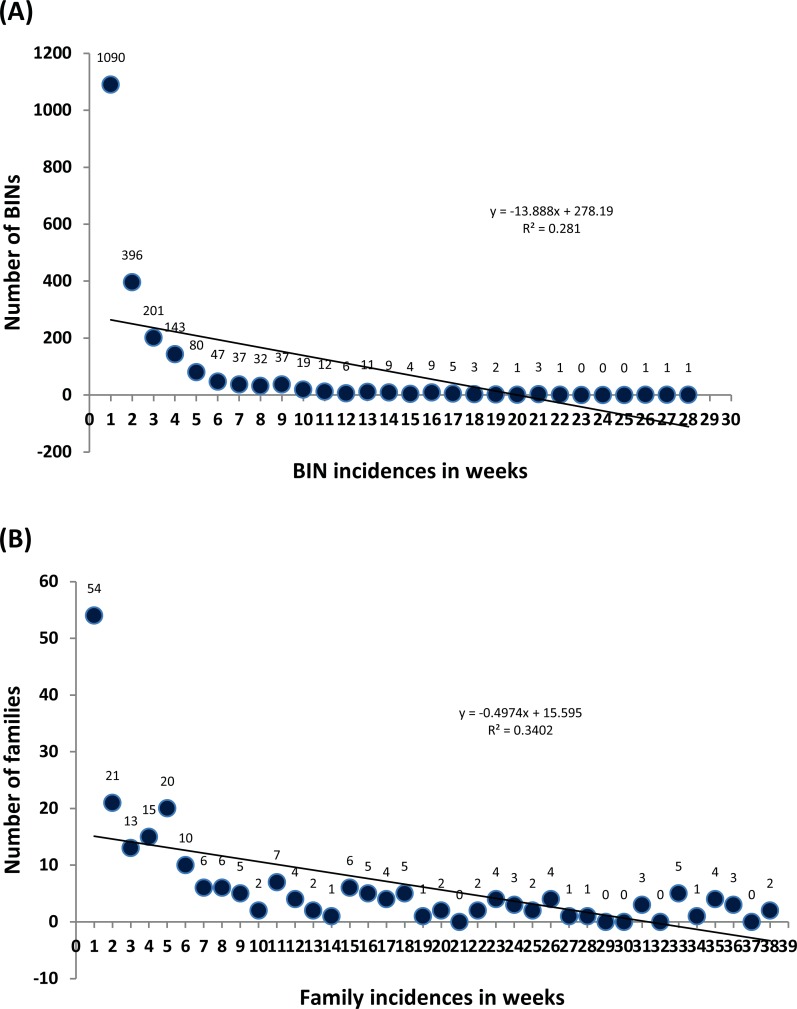
Incidence of BINs (A) and families (B) in the 39 collections from Islamabad, from February to December 2012.